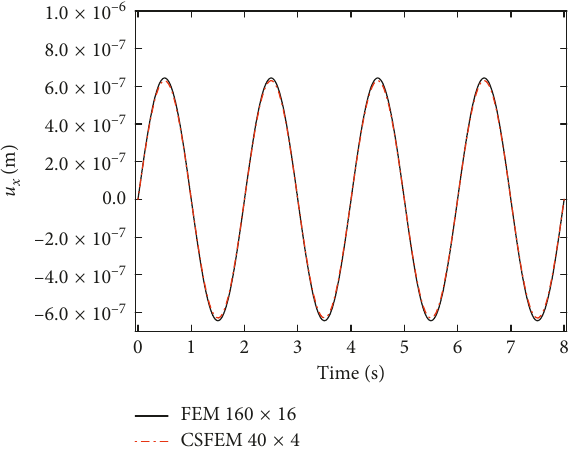
Figure 17: The variation of the displacement u respect to time.